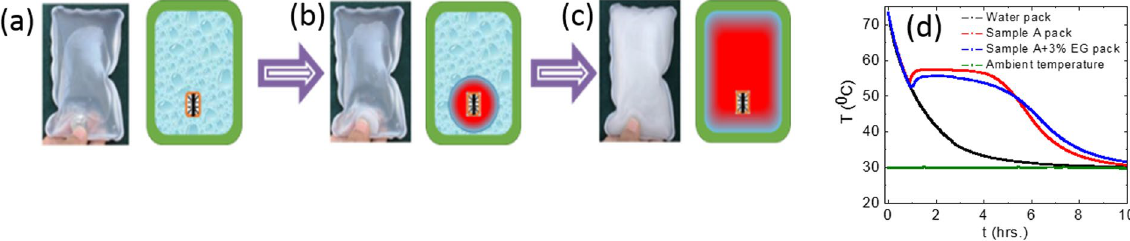
Figure 7. Schematic and pictorial representation of heat releasing process from PCM heat packs: ( a ) flexing triggering device to start nucleation in supercooled liquid PCM for its solidification at t = 0 second, ( b ) growth of solidification at t = 5 seconds, ( c ) complete solidification of supercooled liquid PCM at t = 55 seconds and ( d ) T-history curves for heat packs consisting of water, sample A and C.